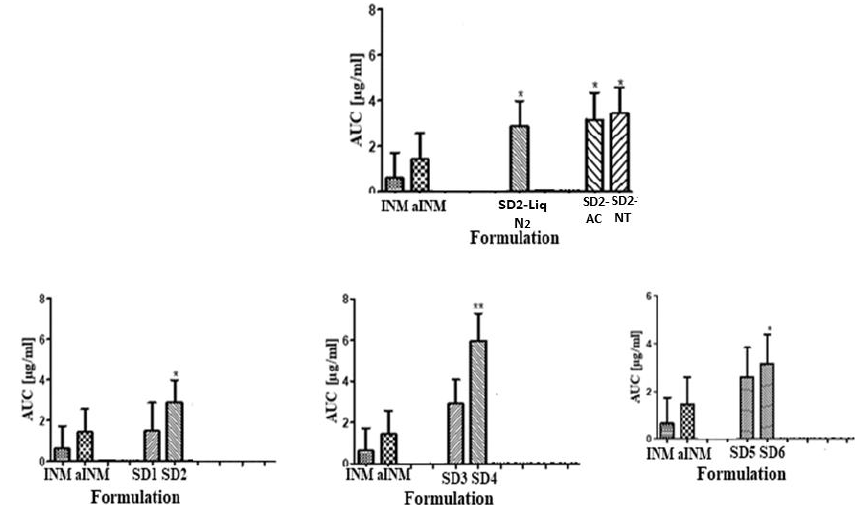
Figure 13. Graphical representations of AUC of quaternary and ternary SD formulations in pH 1.2. ** and * represents the statistical difference ( p < 0.05) between ASD, amorphous INM and pure INM respectively, for the one-way ANOVA and Tukey–Kramer post hoc test. (AC = Air cooled, NT = Normal room temperature and Liq N 2 = Liquid Nitrogen).